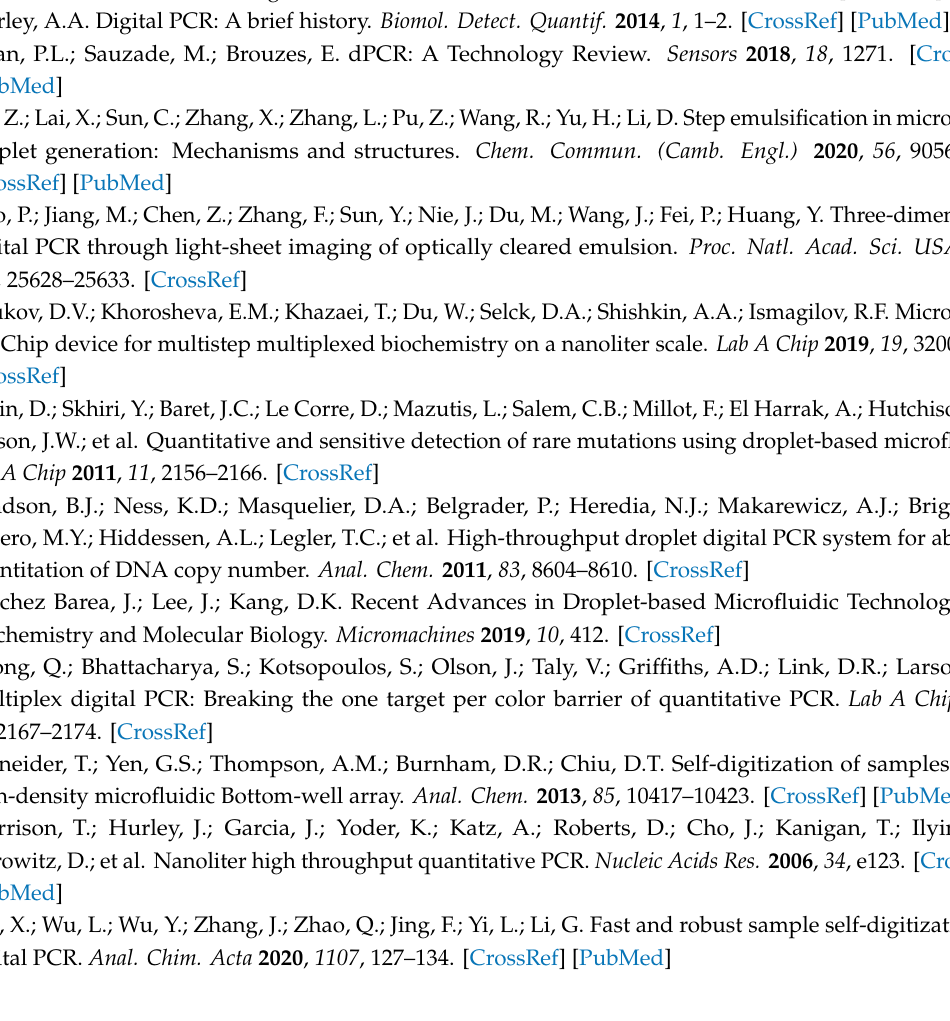
Figure S1: Schematic illustration of the fabrication process for the double-deck dPCR chip. (A) Preparing SU-8 master; (B) pouring PDMS over the master mold; (C) releasing the PDMS replica; (D) bonding the PDMS replica to a bottom glass slide by plasma treatment; (E) bonding the PDMS replica to a pre-punched top glass slide by plasma treatment; (F) bonding the PDMS-glass block and valves, Table S1: Sequences of primers and probes used in this